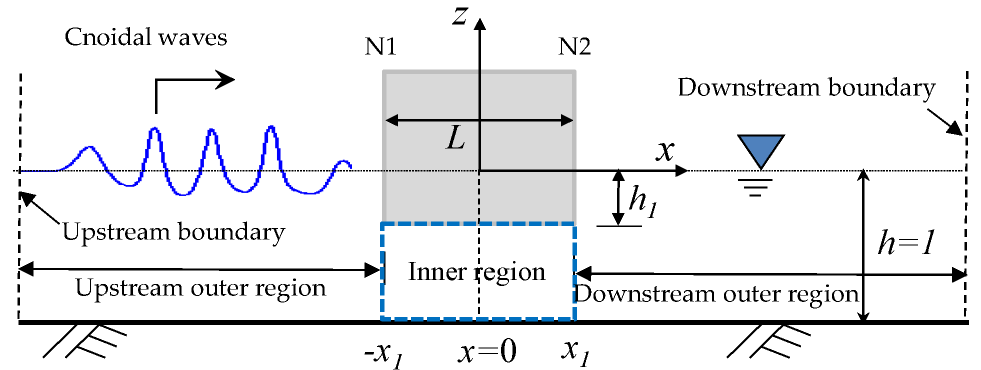
Figure 1. A schematic diagram showing the fluid domains for the analyses of an incident cnoidal wave encountering a fixed and partially submerged rectangular body.